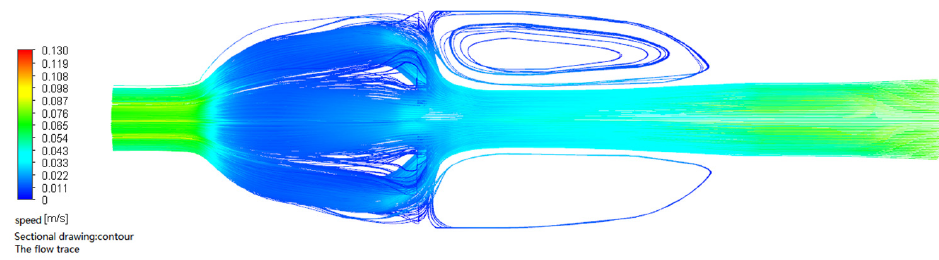
Figure 14. The flow field simulation cavity structure without steady flow plates.